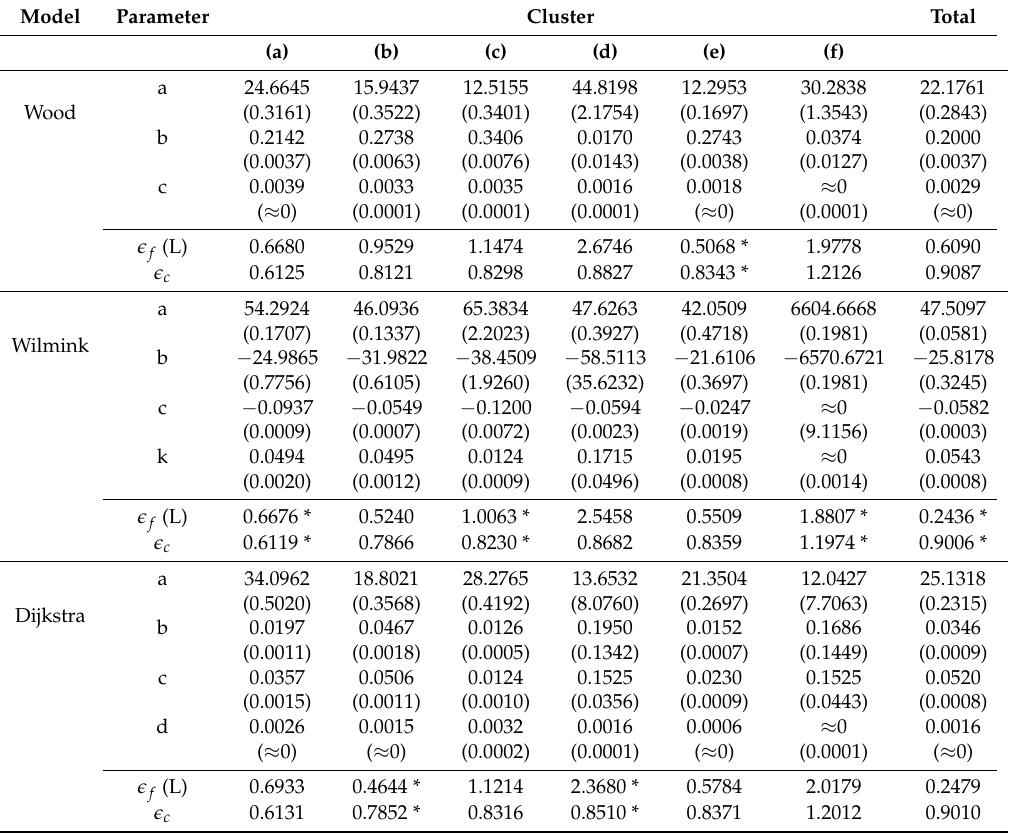
Table 5. The regression parameters and the RMSE results per each